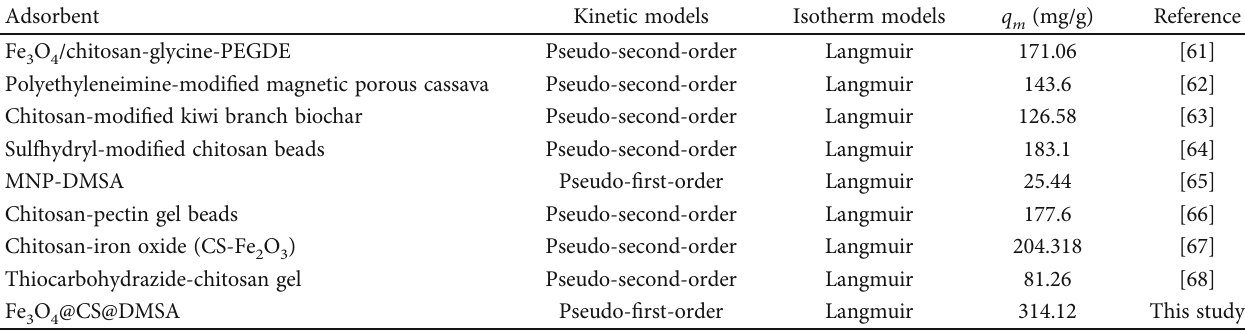
Table 3: Comparison of Cd(II) adsorption performance on Fe Adsorbent